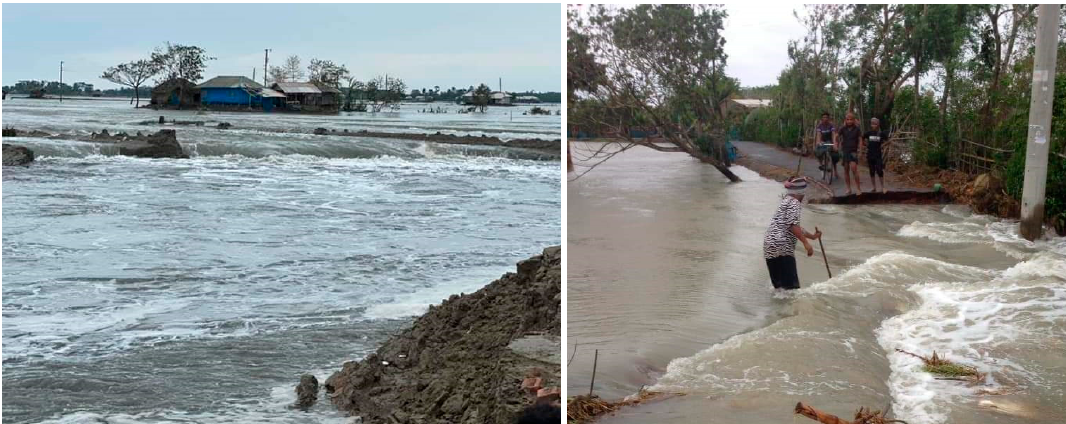
Figure 1. The aftermath of super cyclone Amphan induced flooding in the study area. The images on the left show the excessive surface runoff occurring in the village and crop fields. The image on the right shows the riverbank failure surrounding the village in Koyra, Khulna. Images were taken on 22